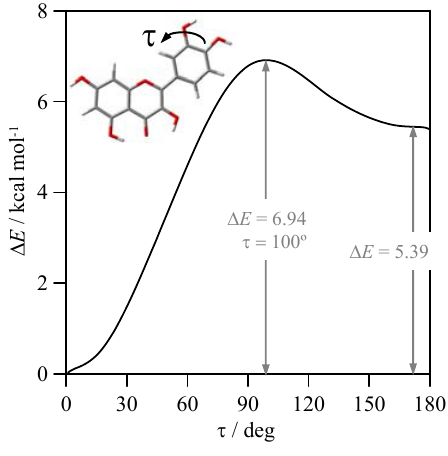
Figure 7. Relaxed potential energy scan for the reported dihedral (involved in HB_5 as in Figure 4) in flavonoid XIII (quercetin), calculated in gas phase at B3LYP ⁄ 6-311++G** theoretical